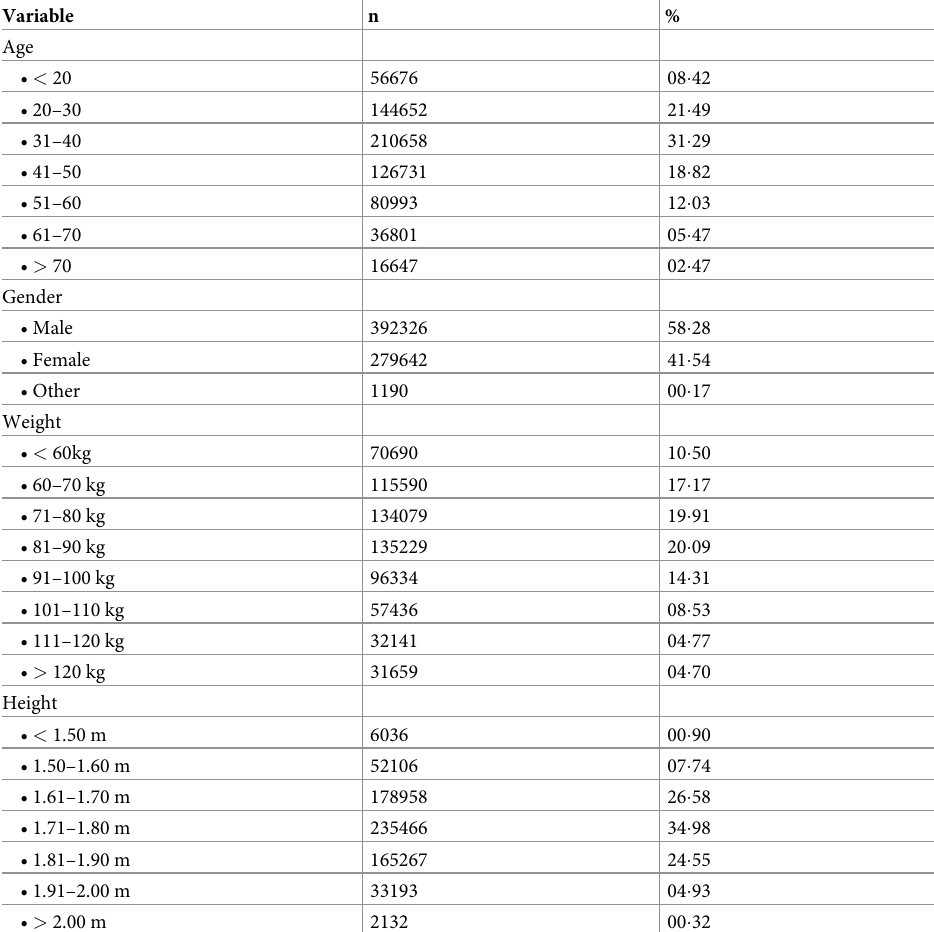
Table 1. Base characteristics of the study population.